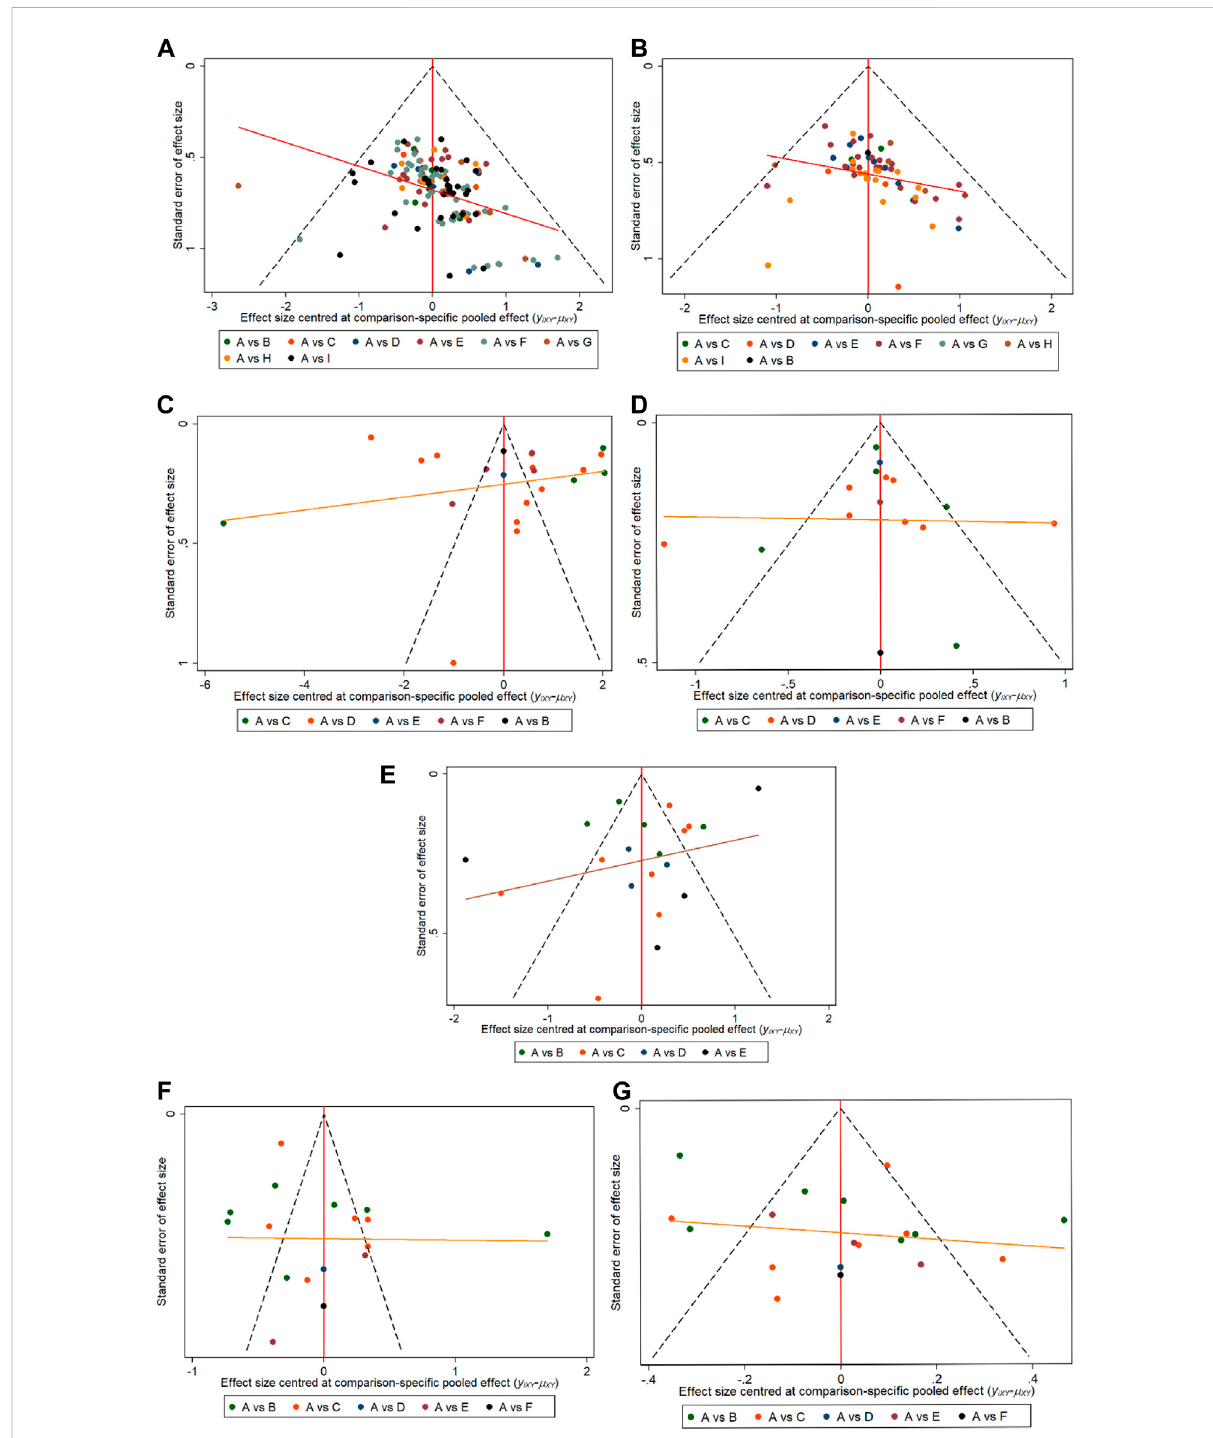
FIGURE 8 Comparison-correction funnel chart for ending indicator, (A) Inclusion of total effective rate; (B) ECG ef fi cacy; (C) Angina pectoris attack (weeks); (D) Angina pectoris attack (days); (E) hs-CRP; (F) TC; (G)